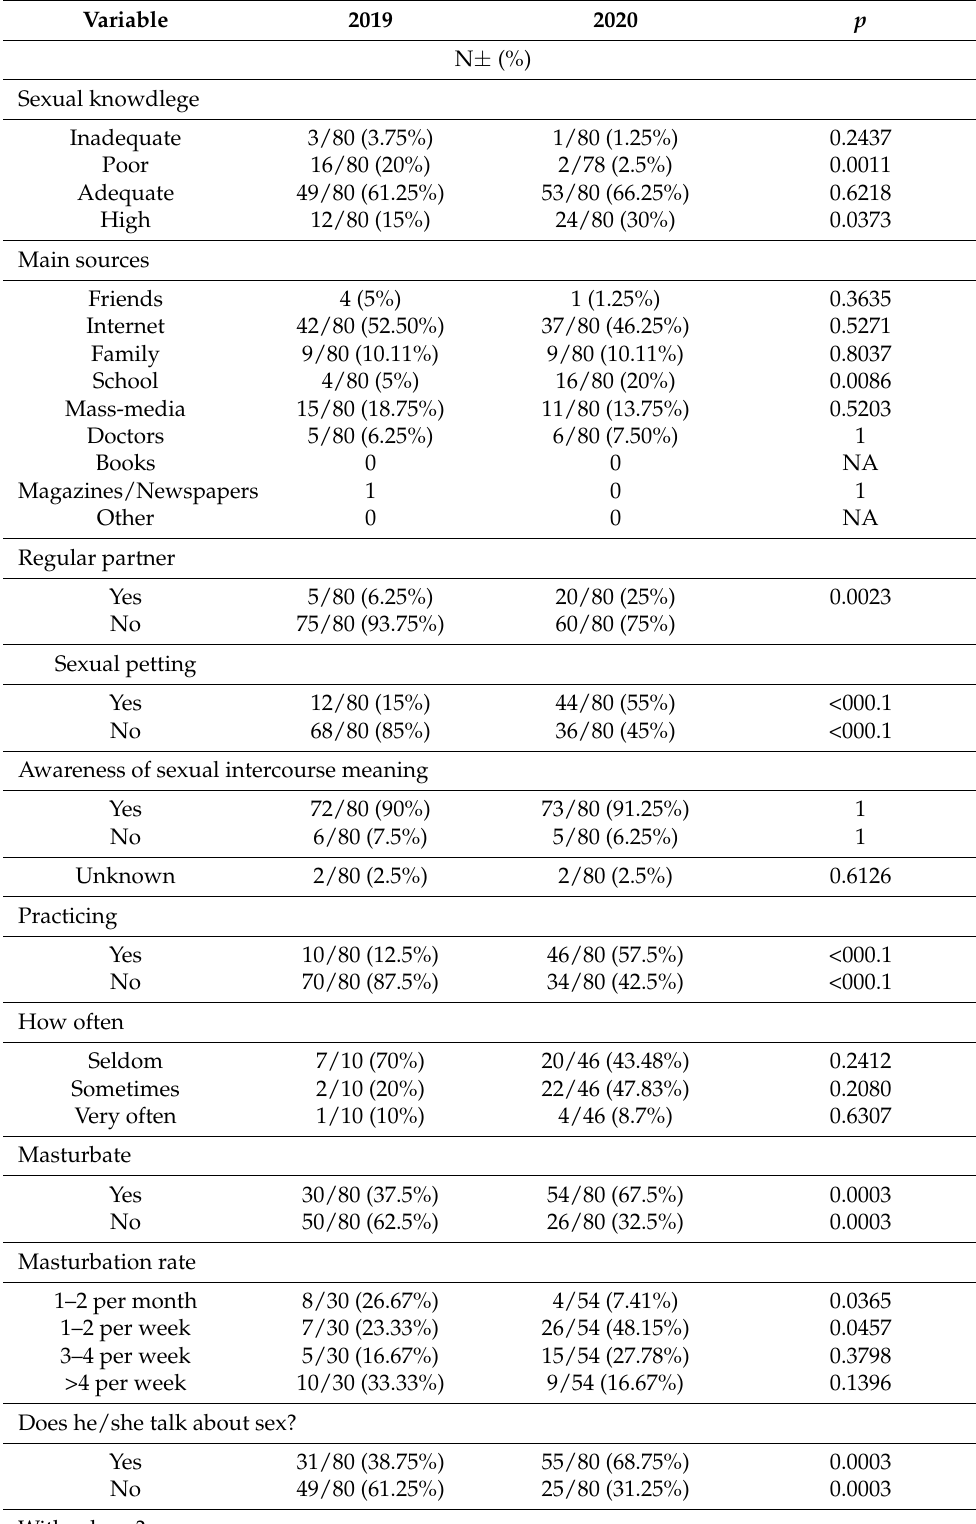
Table 3. Comparison between surveys one year later: